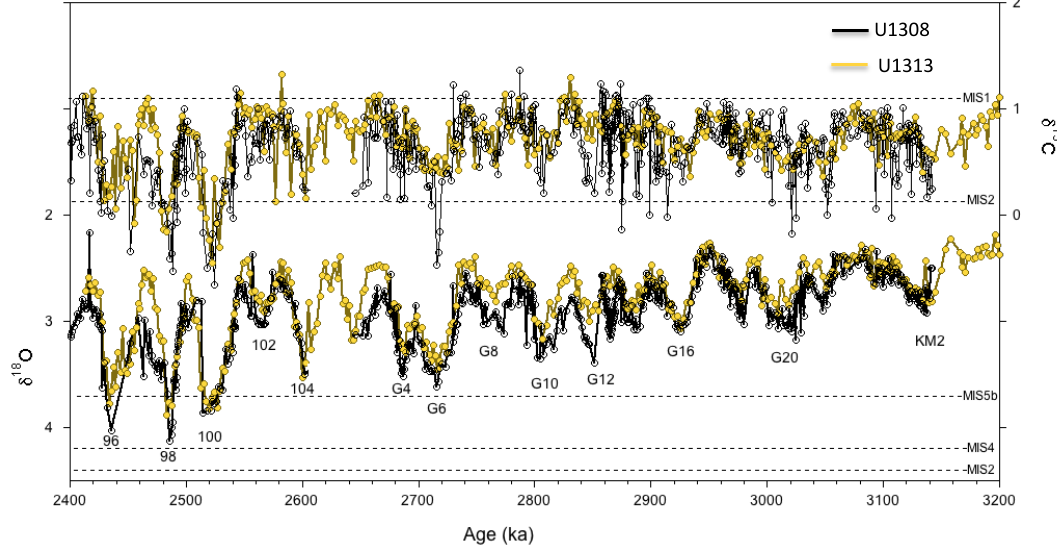
Figure 4. Benthic oxygen and carbon isotope records for IODP Site U1308 (black) and Site U1313 (gold; Bolton et al., 2010; Lang et al., 2016). Prominent marine isotope stages are labeled and δ 18 O values corresponding to MIS 5b, 4, and 2 are marked for reference. Dashed lines indicate the δ 13 C values of MIS 1 and 2 for δ 13